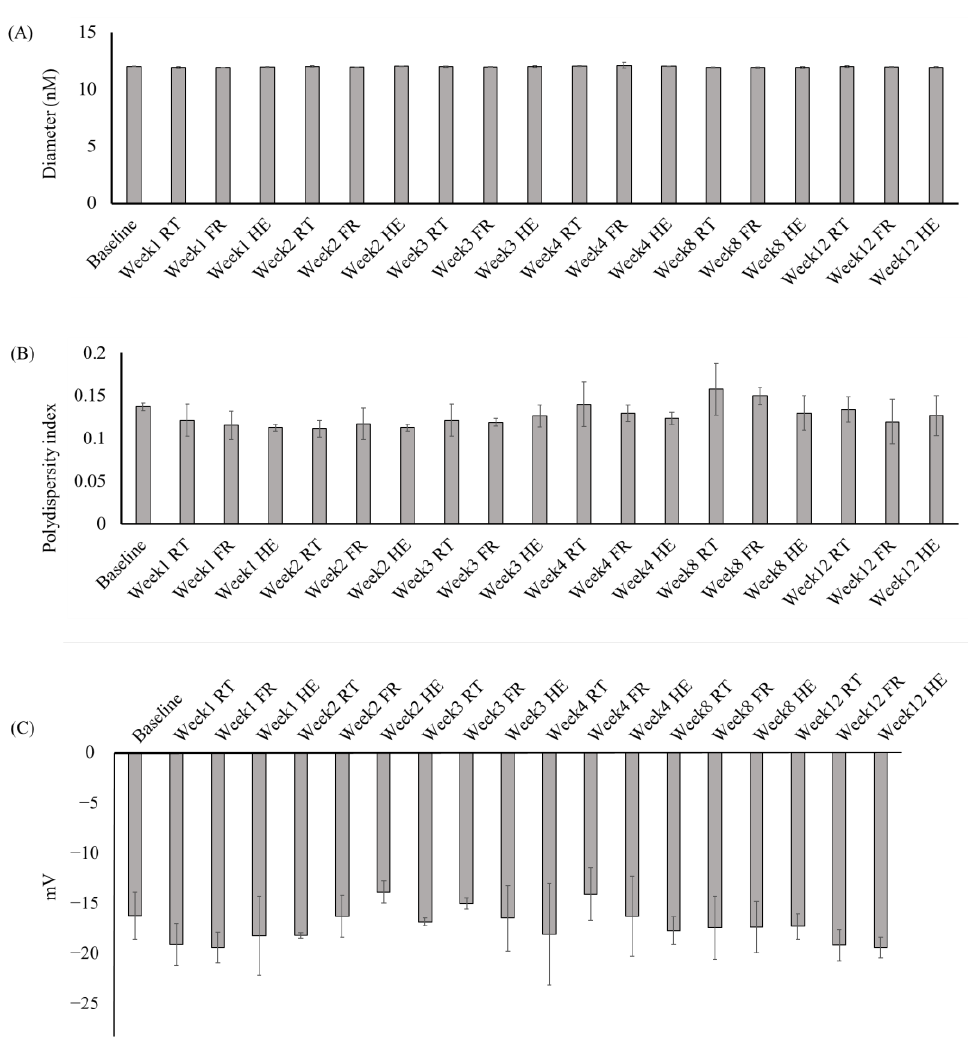
Figure 4. The changes in the diameter ( A ), polydispersity index ( B ), and zeta potential ( C ) of the MELM were stored under different conditions for 12 weeks.